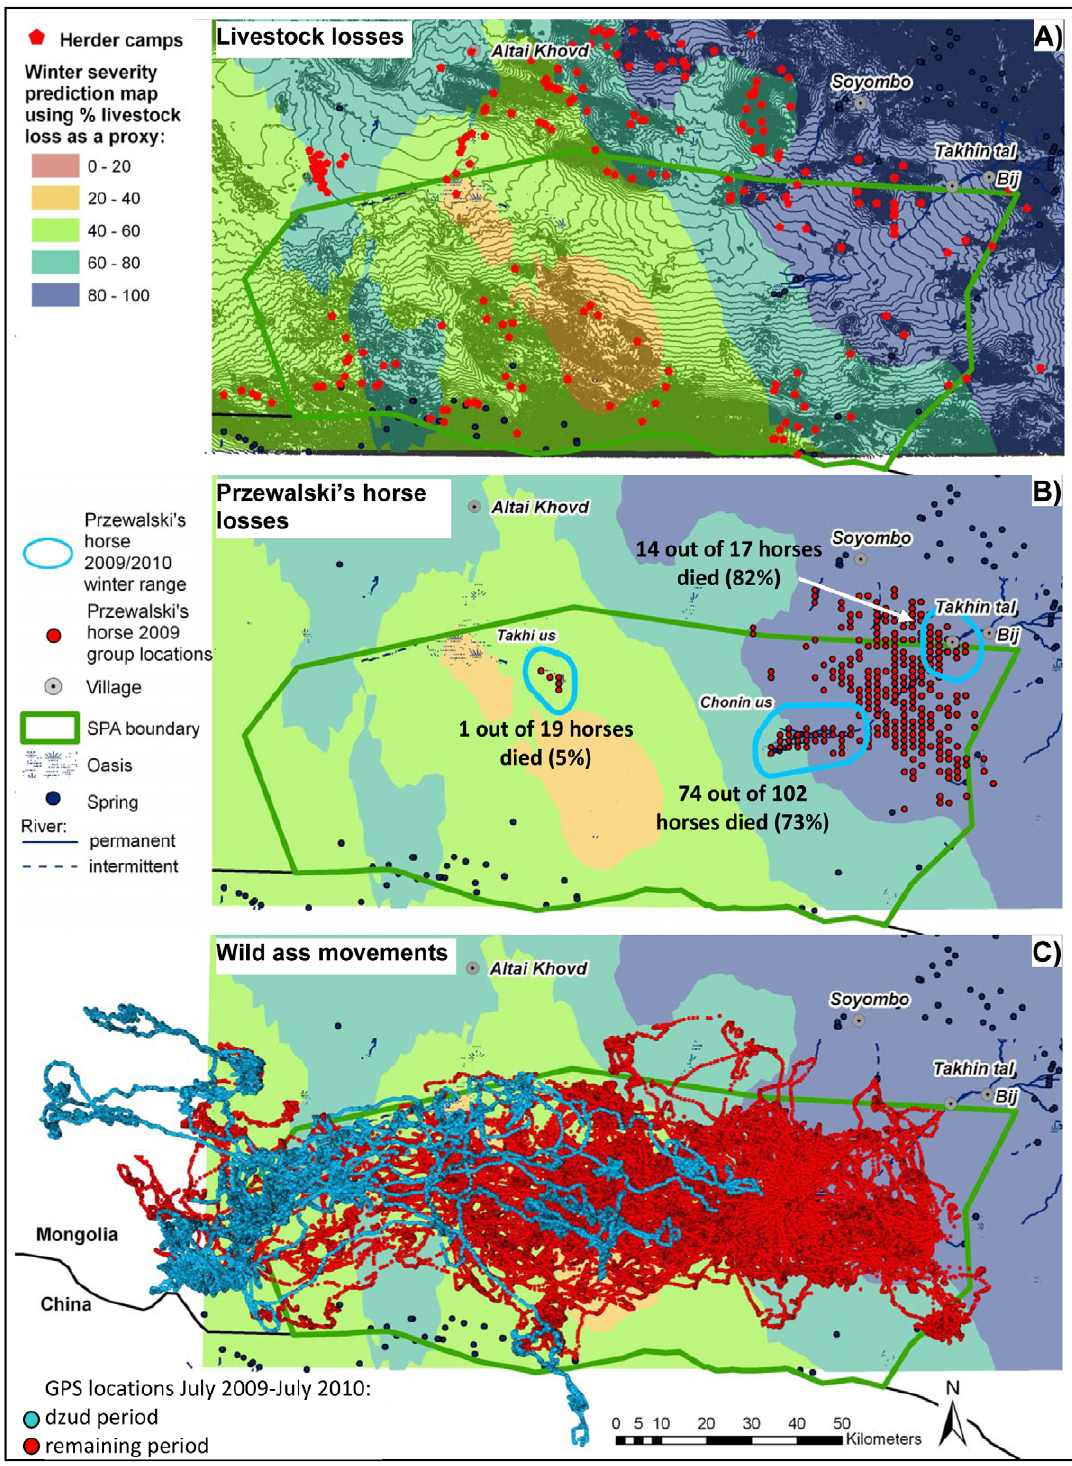
Figure 1. Impact of the 2009/2010 dzud winter on local nomads and two wild equid species in the Great Gobi B Strictly Protected Area in south-western Mongolia. A) Livestock loss prediction map as a proxy for winter severity based on the average % total livestock loss at 219 herder camp locations using ordinary kriging, B) Winter losses among the re-introduced Przewalski’s horse population as a function of their respective winter ranges. The total distribution range in 2009 is based on group locations of 12 harem and 1–3 bachelor groups of Przewalski’s horses on 129 observation days from January through December 2009. C) Movement patterns of Asiatic wild asses based on GPS positions of 10 wild asses followed from July 2009 to July 2010 (N=355,618). Blue dots mark locations during the dzud period (N=99,220) and red dots locations during the rest of the monitoring period.